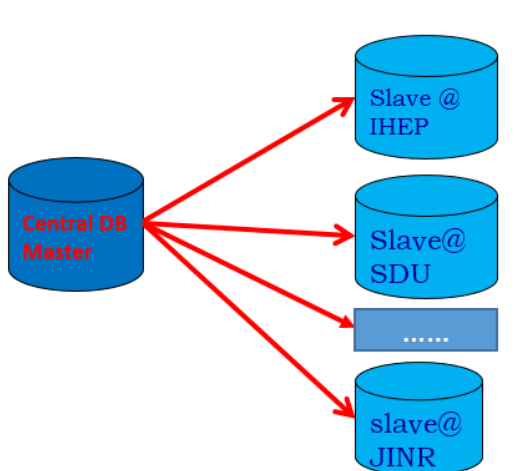
Fig. 6. The picture shows the replication pattern of BESIII Central Database